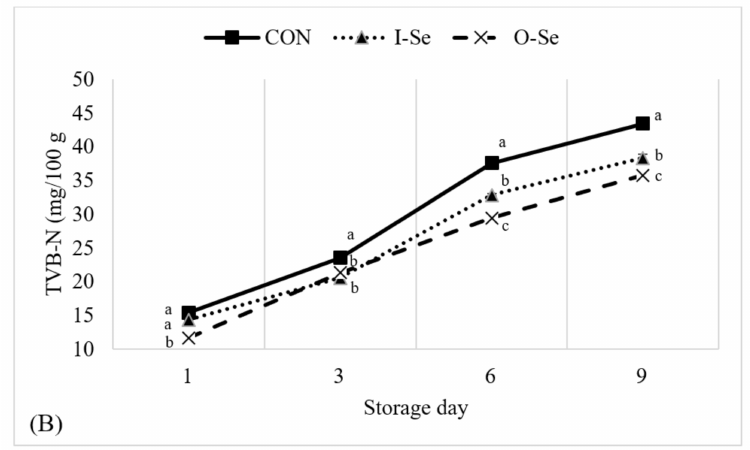
Figure 4. Effects of dietary supplementation with inorganic or organic selenium on the total volatile basic nitrogen (TVB-N) for goose meat (equal portions of the breast and thigh meat) ( A ) and liver ( B ) during 9 days of storage at 4 ◦ C. Treatments were defined as CON: basal diet without supplemental selenium; I-Se: basal diet with 0.3 mg/kg inorganic selenium; O-Se: basal diet with 0.3 mg/kg organic selenium. Means within the same day with differing letters are different ( p <